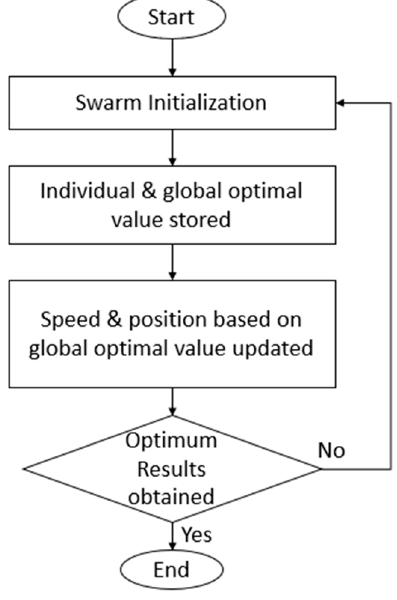
Figure 4. The genetic algorithm process, as adapted from Ref. [40].